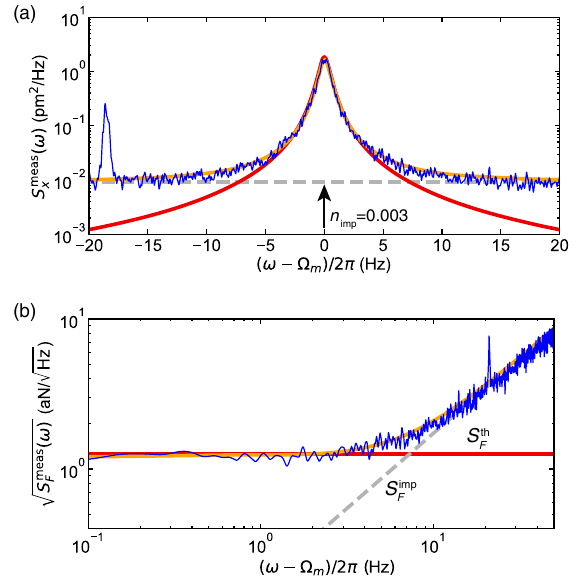
FIG. 5. Feedback cooling and thermal-noise-limited force sensing. (a) Displacement fluctuation PSD of the feedback cooled perimeter mode. Blue line: experimental data. Orange line: Lorentzian fit to the data which gives a total linewidth of Γ 2 π × 1 . 0 Hz. Red line: expected Brownian motion PSD. tot ¼ Dashed gray line: the imprecision noise background in the displacement measurement. (b) Force noise PSD. Blue and orange lines are the experimental data and the Lorentzian fit shown in (a), divided by the effective susceptibility [Eq. (7)]. Red line: the expected thermal force PSD. Dashed gray line: con- tribution from